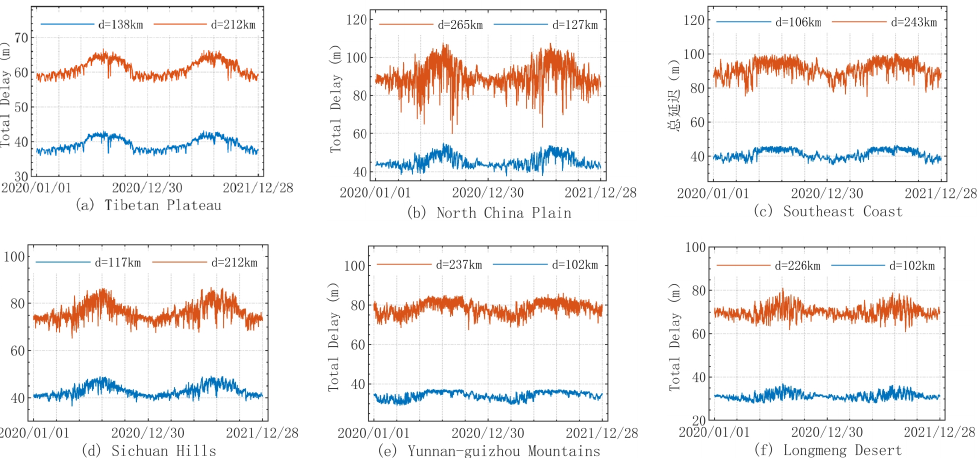
Figure 7. Total scattering propagation delay of 12 links. These six subfigures show the total delay of 12 links in different regions: ( a ) Tibetan Plateau, ( b ) North China Plain, ( c ) Southeast Coast, ( d ) Sichuan Hills, ( e ) Yunnan–guizhou Mountains, ( f ) Longmeng